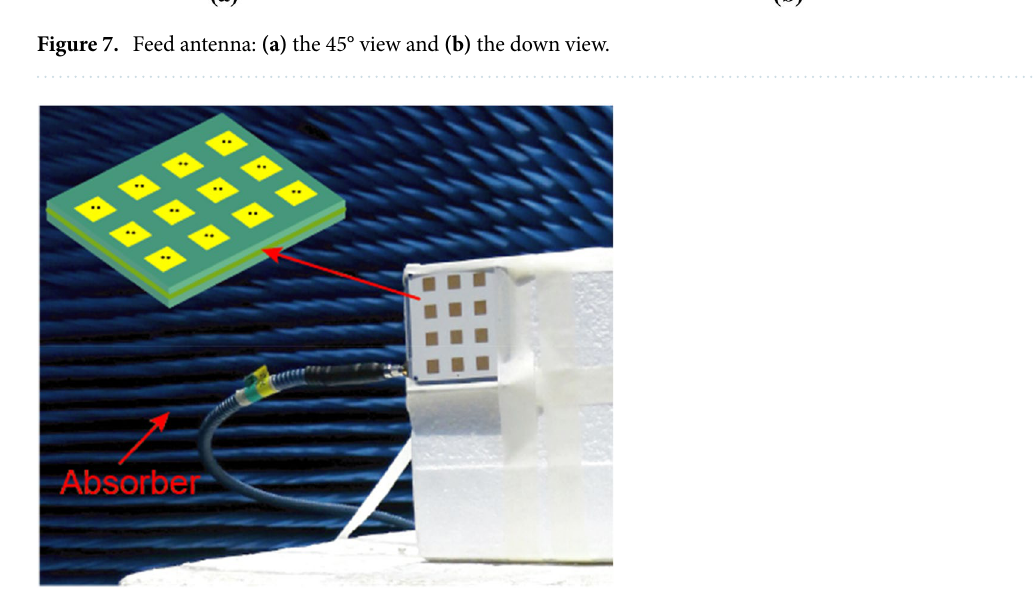
Figure 8. Photograph of the feed array in an anechoic